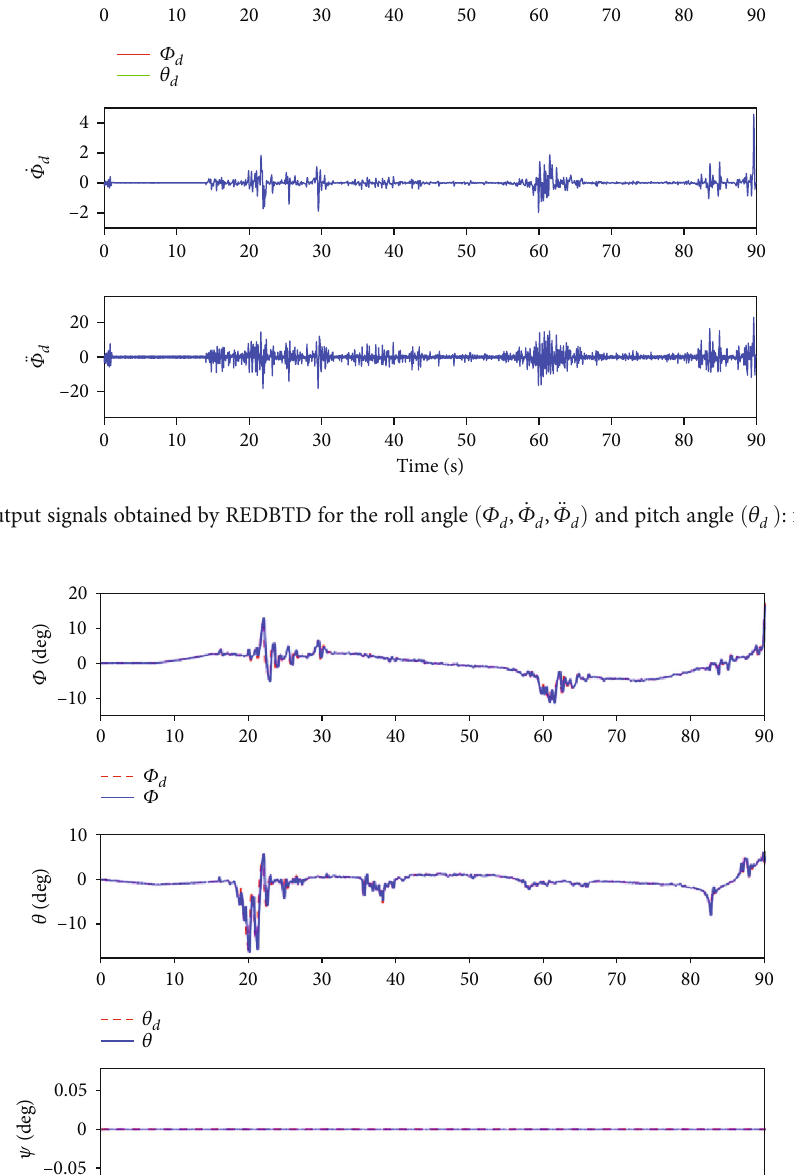
Figure 10: Pro fi les of the attitude of the quadrotor: Rotational variables ð Φ , θ , ψ Þ : fl ight scenario